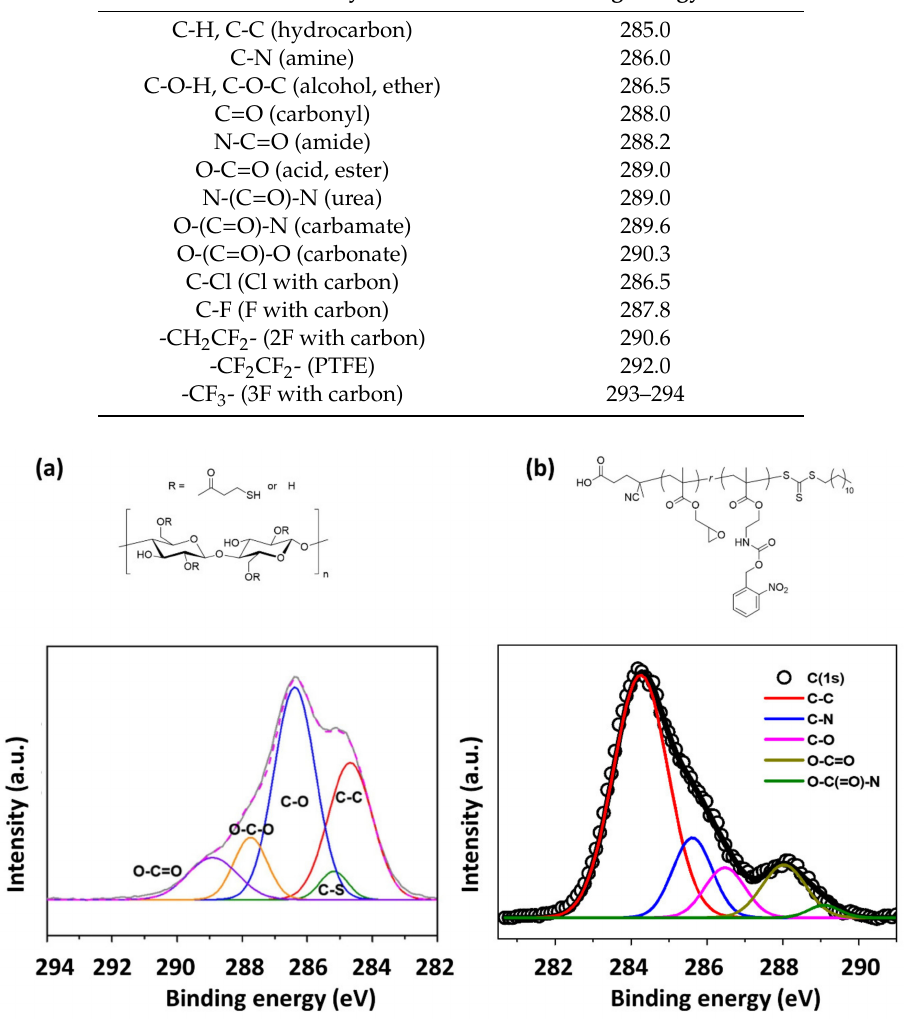
Figure 2. Deconvoluted C(1s) multiplex spectra of ( a ) a thiol-functionalized cellulose nanofiber mat (Reproduced from Reference [50] with permission from Elsevier) and ( b ) a photo-crosslinked thin film of poly(2-((((2-Nitrobenzyl)oxy)carbonyl)amino)ethyl methacrylate- r -glycidyl methacrylate) (Reproduced with permission from Reference [51]; Copyright (2015) American Chemical